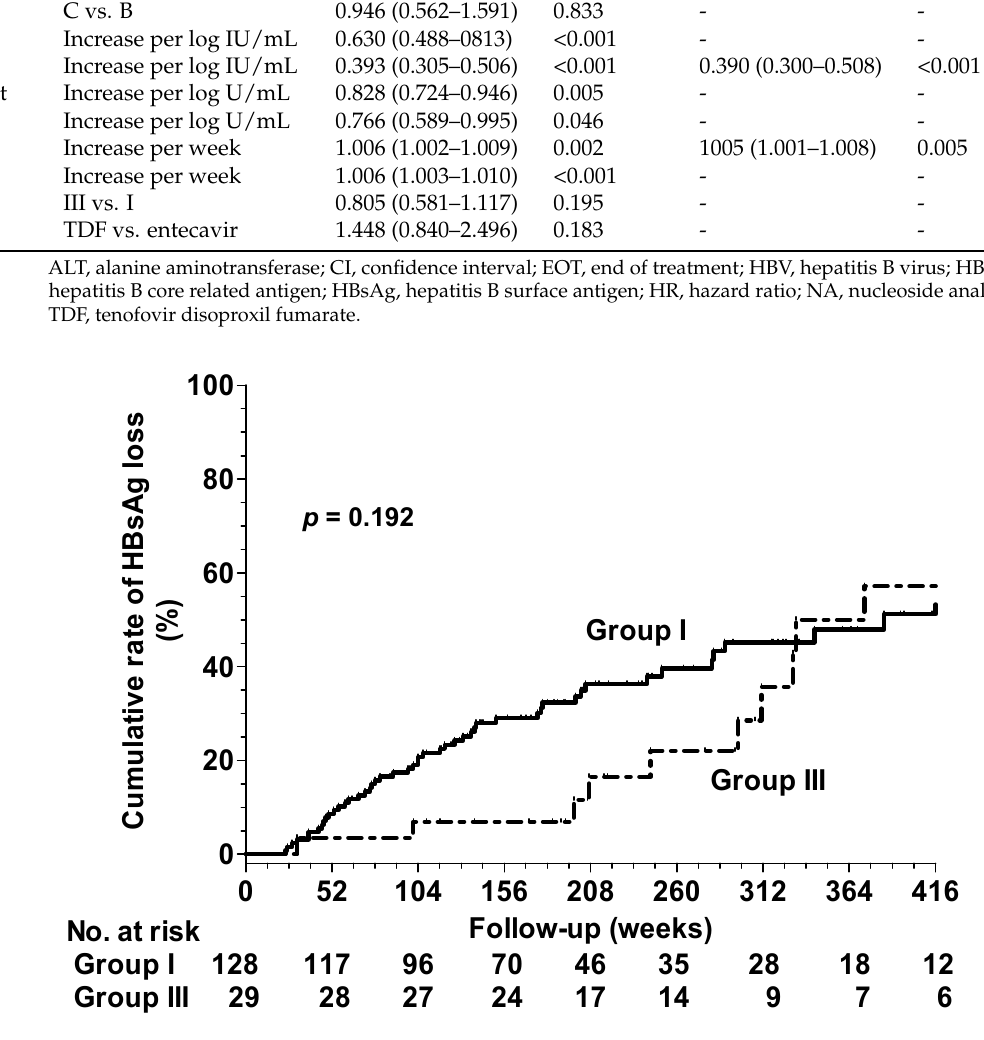
Figure 2. HBsAg loss rates between Group I and Group III.